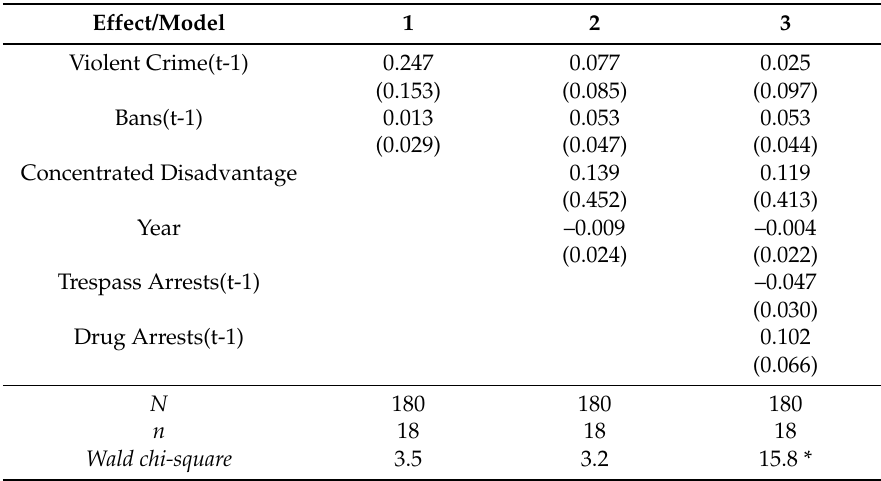
Figure 4. Violent crimes in public housing by year. Table 4. Arellano–Bond dynamic panel-data models predicting violent crime.